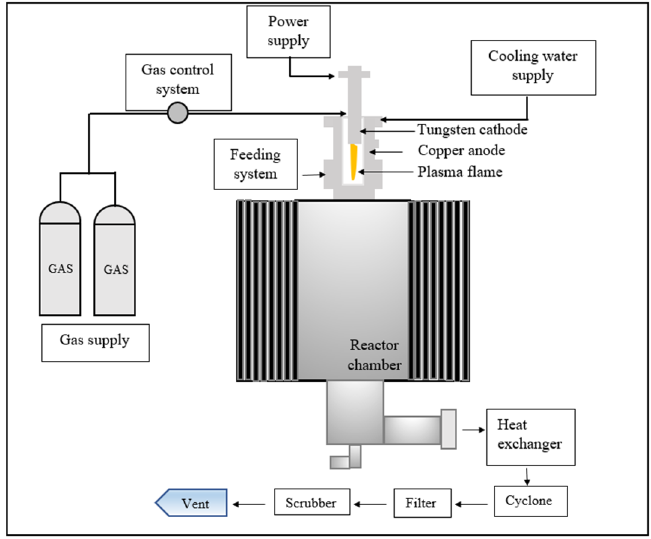
Figure 1. Non-transferred plasma reactor diagram.